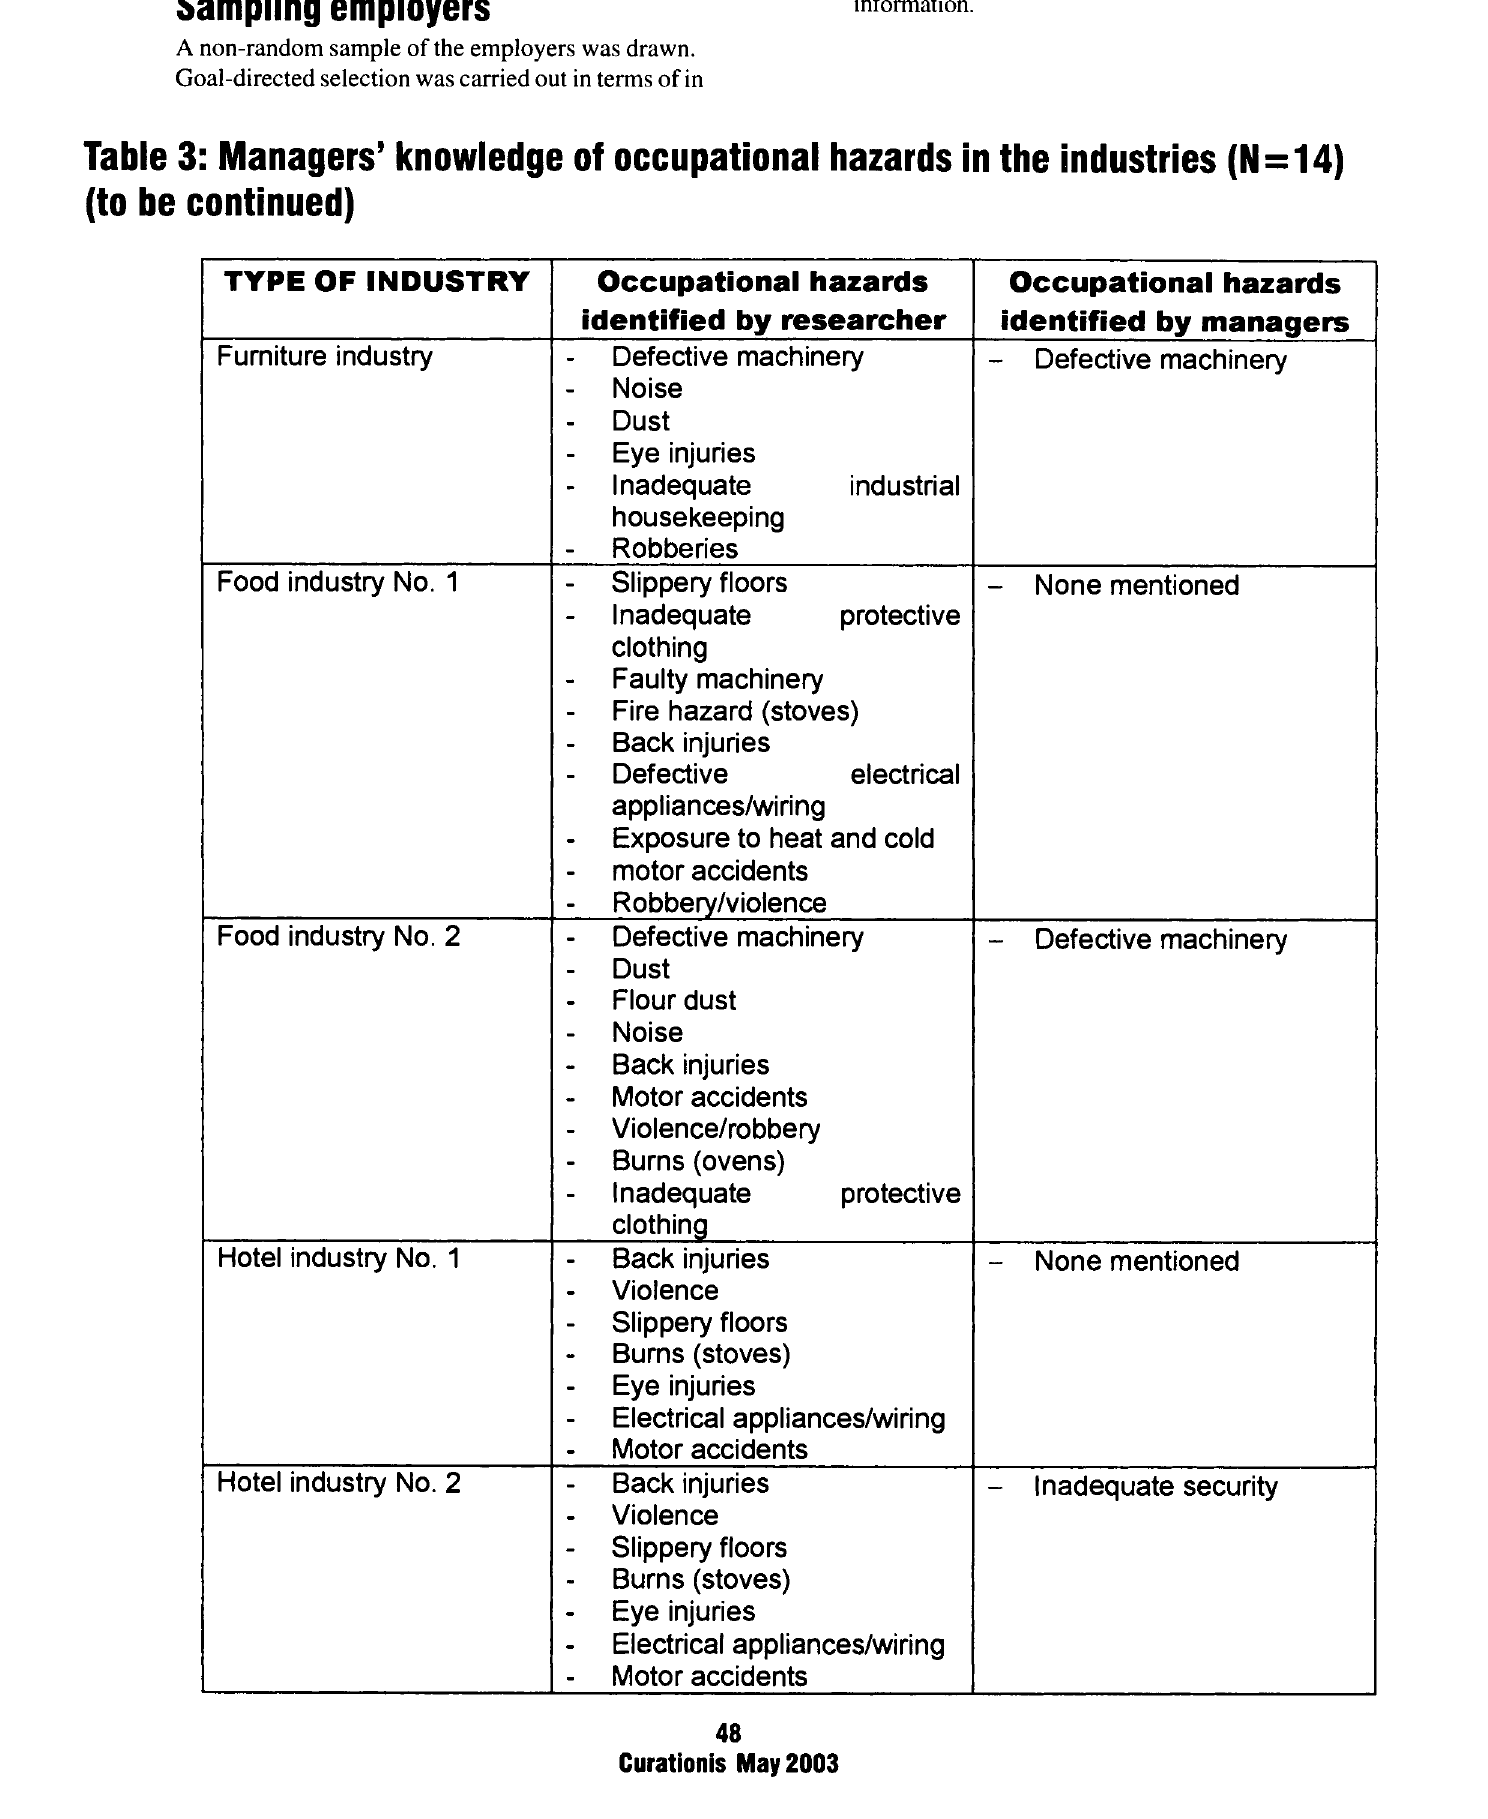
Table 3: Managers’ knowledge of occupational hazards in the industries (N=14) (to be